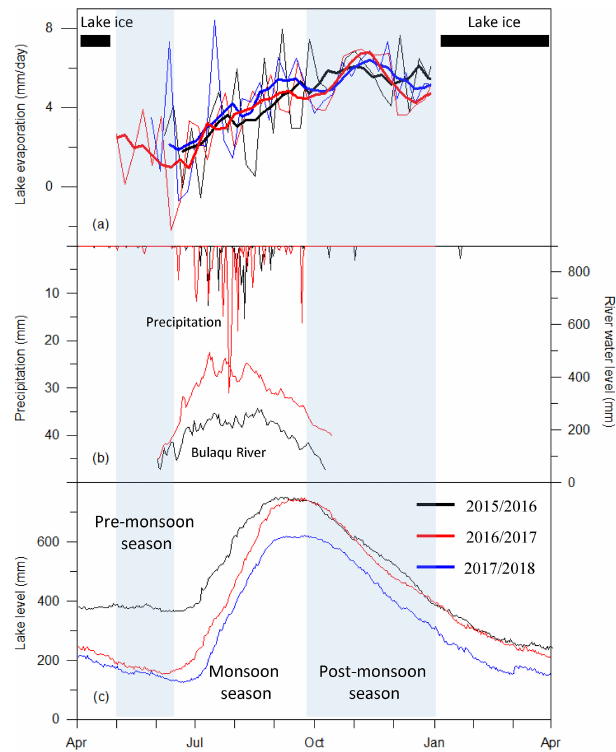
Figure 7. The main components of the lake water budget at Paiku Co between 2015 and 2018. (a) Lake evaporation (mmd − 1 ) derived from the north shoreline of Paiku Co. (b) Daily precipitation ( mm ) at Qomolangma station and water level ( mm ) of Bulaqu River in 2015 and 2016. Note the y axis (left) of precipitation is reversed. (c) Daily lake level ( mm ) at Paiku Co. The thick lines in (a) denote the five-point running average. The blue rectangles represent pre- monsoon and post-monsoon season periods,